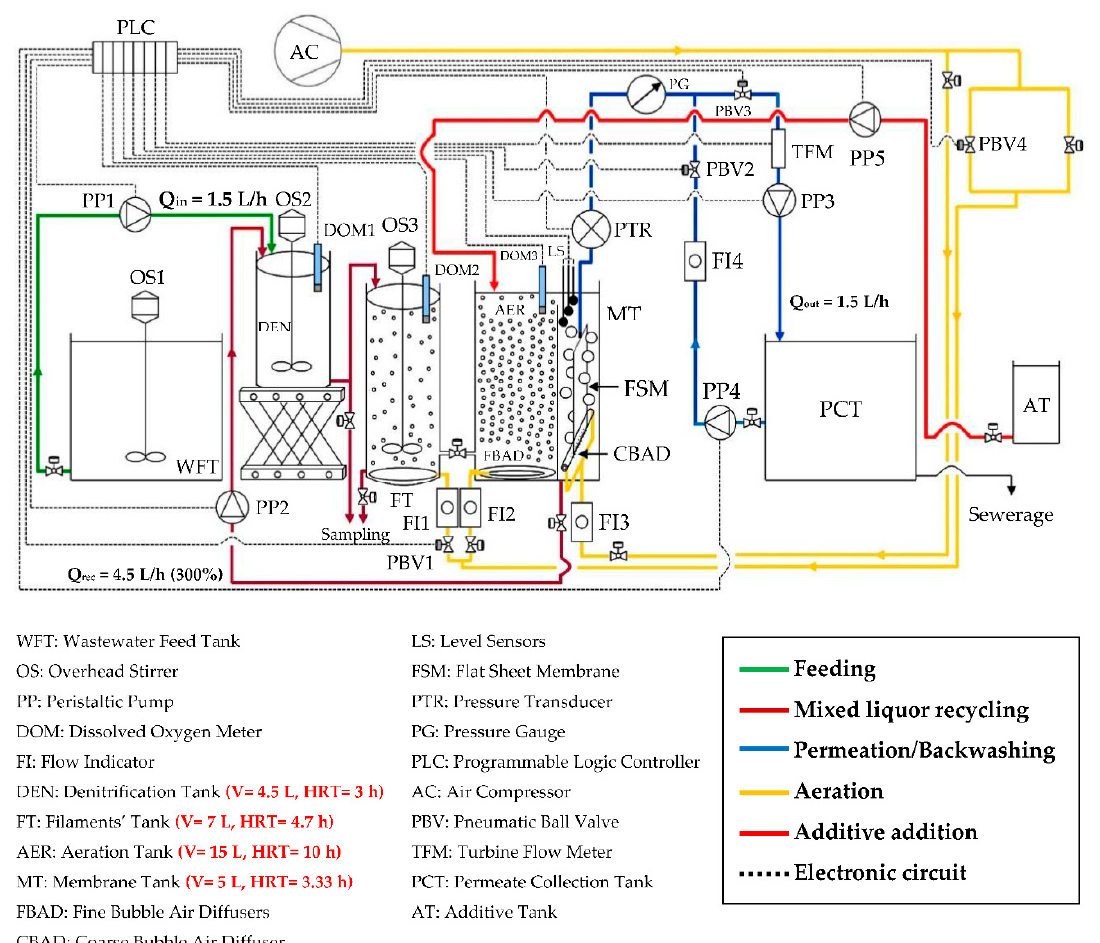
Table 1. Examined parameters in the pilot-scale Membrane Bio-Reactor (MBR).